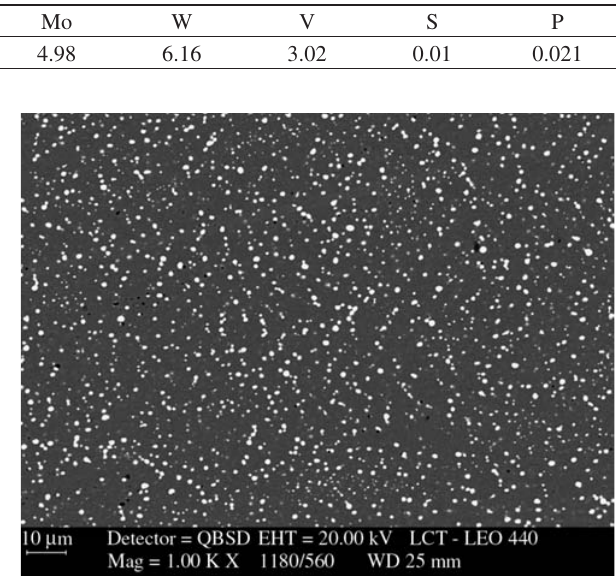
Table 1. Chemical composition of PM Sinter 23. Weight percent and iron balance.